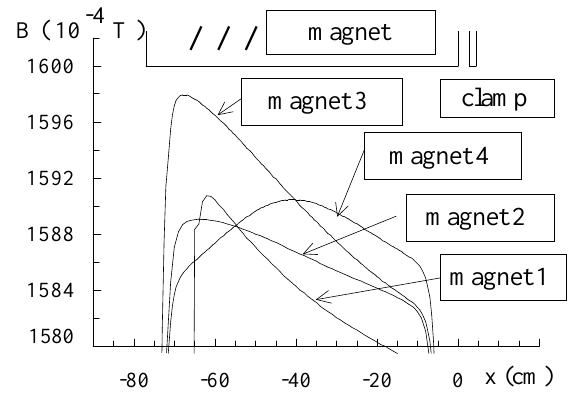
FIG. 2. Magnetic field distributions, in the middle plane, calculated with POISSON for the configurations shown in Fig. 1.